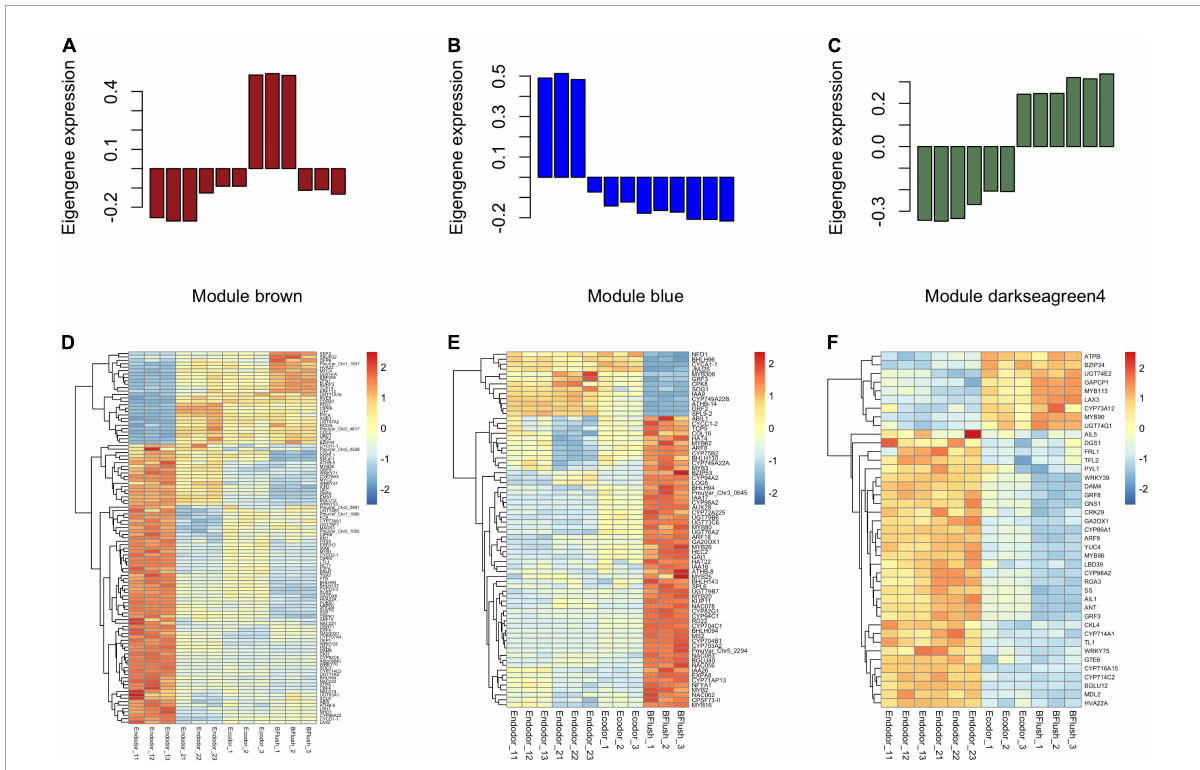
FIGURE3 The co-expressed gene modules associated with dormancy transition in the WGCNA analysis. (A–C) The barplot displaying the normalized eigengene expression for module brown (A) , module blue (B) , and module darkseagreen4 (C) . (D–F) The heatmaps showing the expression pattern of differentially expressed genes within module brown (D) , module blue (E) , and module darkseagreen4 (F)